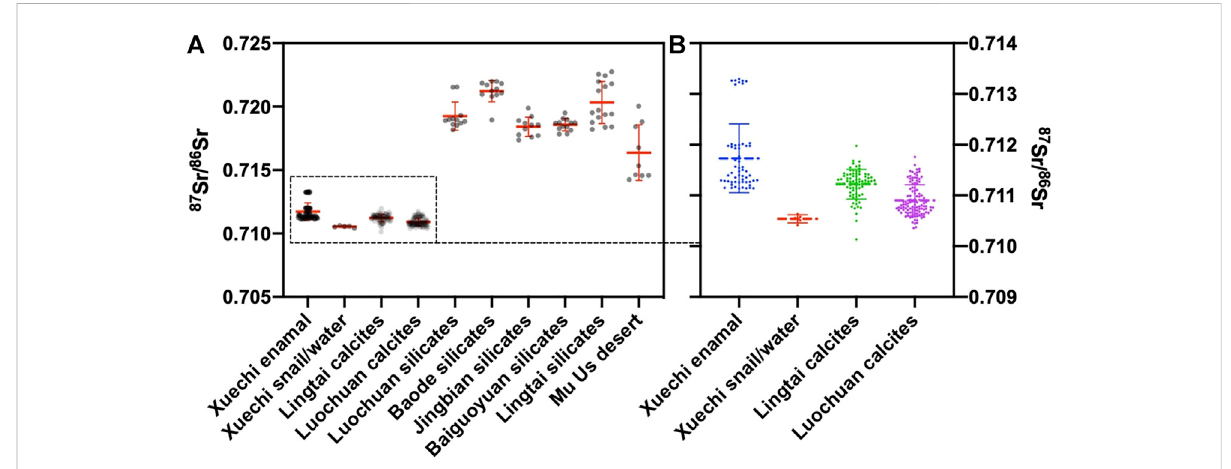
Figure 8B), as well as the riverine water samples (Wang and Tang,